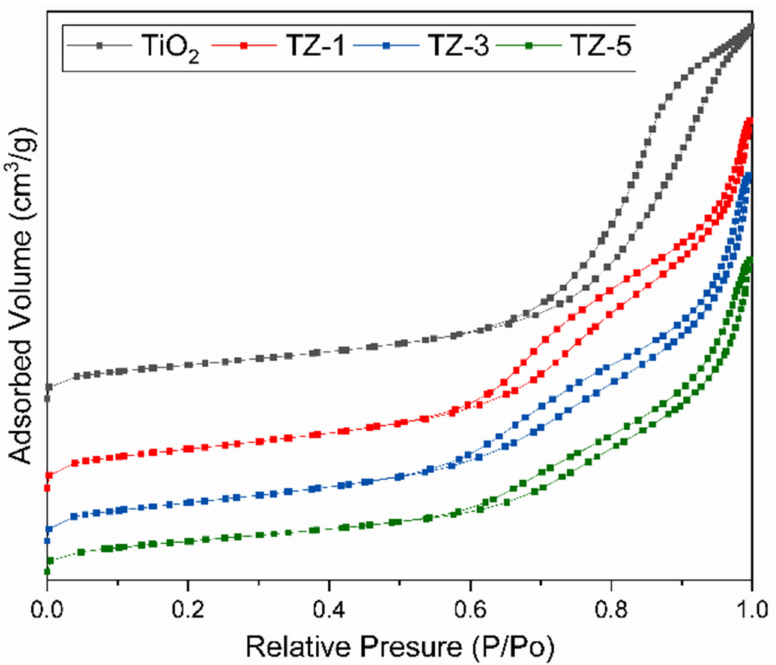
Figure 6. N 2 gas adsorption–desorption isotherms of TiO 2 , TZ-1, TZ-3 and TZ-5